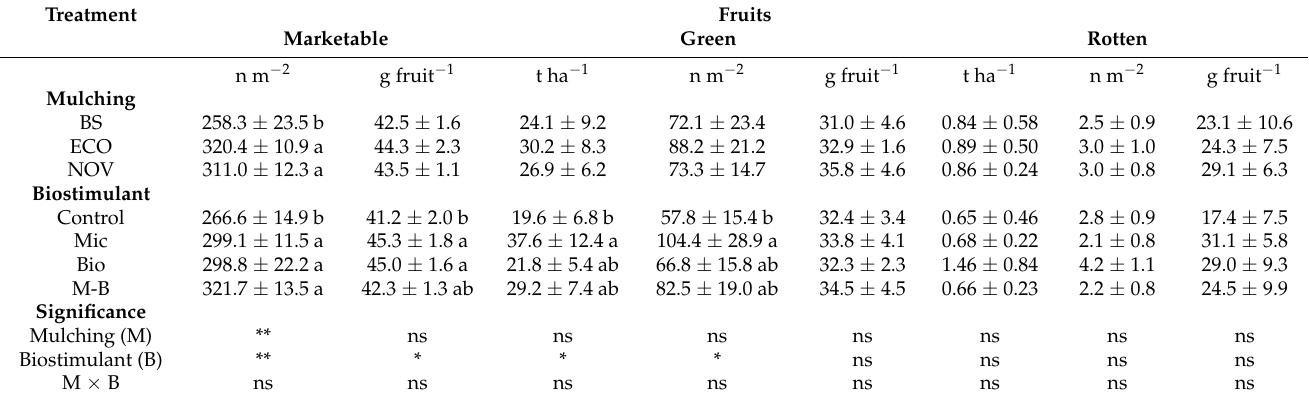
Table 2. Number per square meter and average weight of marketable tomato fruits, and production, number per square meter, and average weight of green, and rotten tomato fruits as affected by mulching (ECO: biodegradable film Ecovio; NOV: biodegradable film MaterBi ® ; BS: bare soil) and biostimulant application (Bio: treated with Phylgreen ® ; Mic: treated with Trianum-P ® ; M-B: combina- tion of Bio and Mic; Control: not treated).